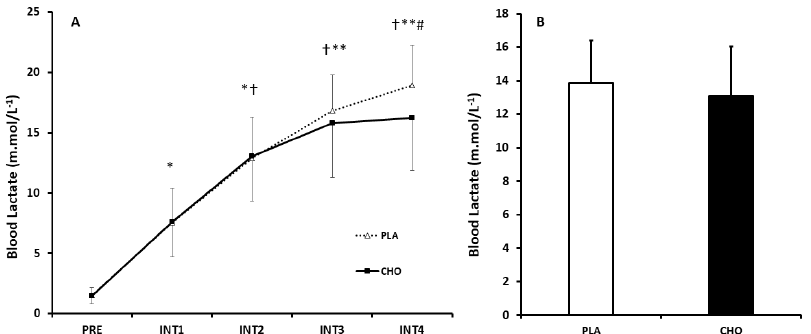
Figure 3. ( A ) Comparison of mean Blood Lactate response between INT1–4 in CHO and PLA trials. Data are Mean ± SD. * Significantly di ff erent to REST ( p < 0.0001); † Significantly di ff erent to INT1 ( p < 0.05); ** Significantly di ff erent to INT2 ( p < 0.05) # Significantly di ff erent to INT3 ( p < 0.05). ( B ) Aggregated blood lactate across intervals.